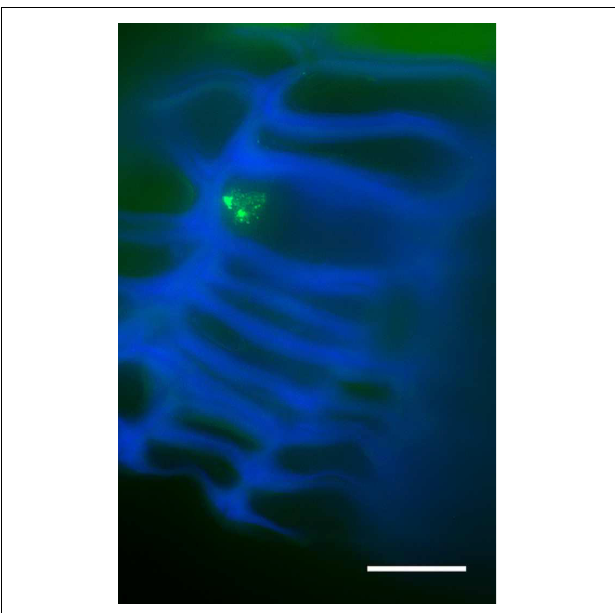
FIGURE 6 | Immunolocalization of histone H3 at lysine 9 (H3K9me2) in cross-sections of one-year-old sprigs shows two condensed chromatin knobs in the periphery of the nucleolus. Bar = 10 µ